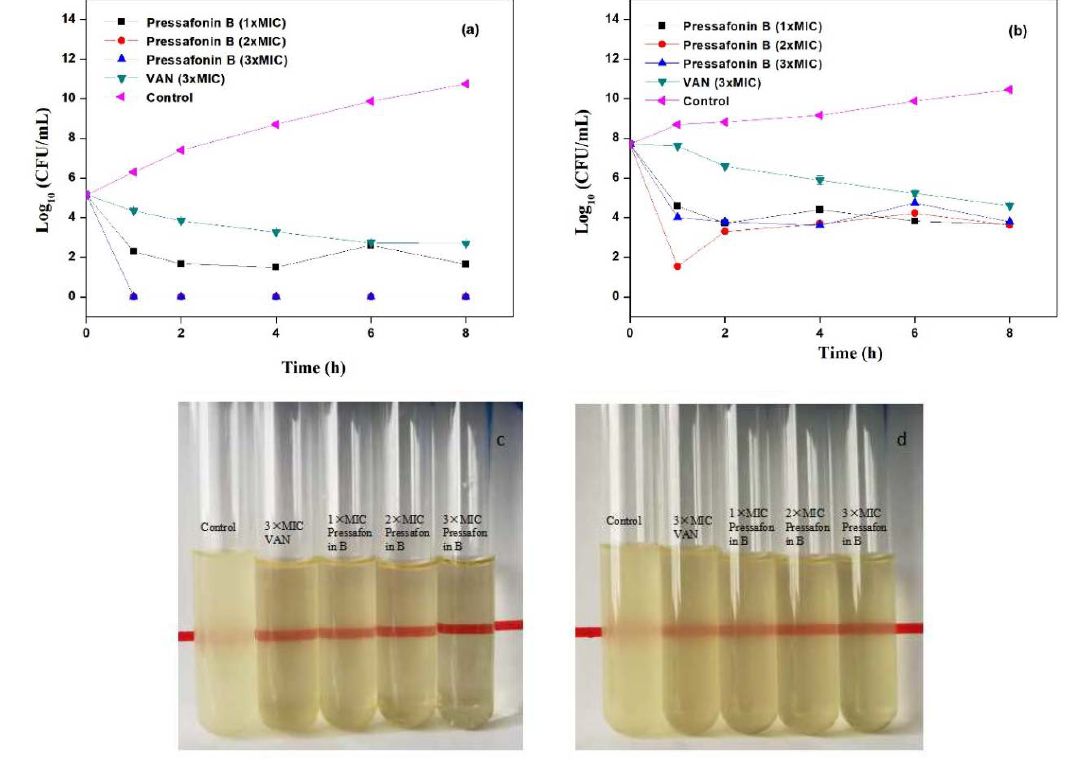
Figure 3. Time-dependent killing of MRSA-3 by compound 7 . ( a , c ) MASA-3 was grown to early exponential phase and was challenged with 7 (at 1×, 2× and 3× MIC) and vancomycin (at 3× MIC); ( b , d ) MASA-3 was grown to stationary exponential phase and was challenged with 7 (at 1×, 2× and 3× MIC) and vancomycin (at 3× MIC); ( c , d ) the bacterial suspension after treatment with compound 7 for 8 h. The control was treatment with sterile water.